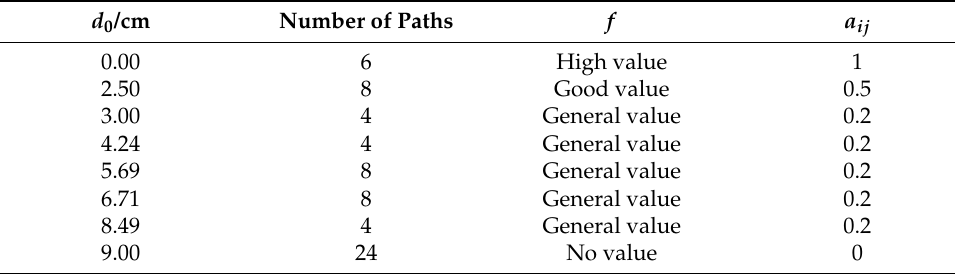
Figure 8. Rectangular coordinate system based on sensor network. Table 5. The optimized DRMS of real defect and simulated